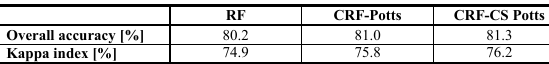
Table 2: Comparison of the overall accuracy and kappa index of results obtained by different models for the interaction potential: independent RF classification ( RF ), Potts model ( CRF-Potts ) and contrast-sensitive Potts model ( CRF-CS Potts ).